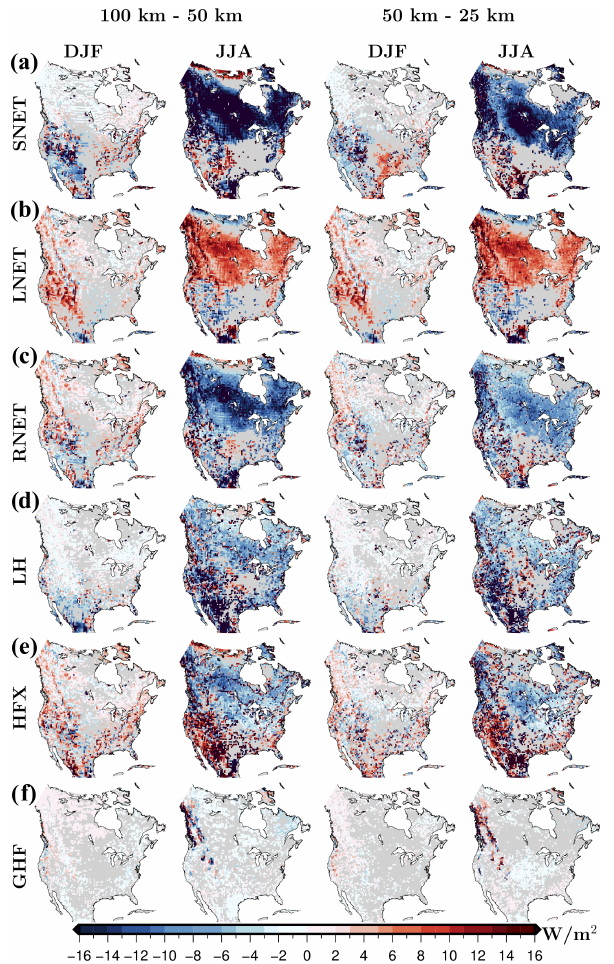
Figure 6. Seasonal mean difference in surface energy fluxes be- tween the 100 and 50km simulations (left) and between the 50 and 25km simulations (right). All outputs are from the NOAH-MP- DV simulations for the period 1980–2013. Grid cells with a non- significant change at the 5% significance level are masked in grey. All outputs from the 25, 50 and 100km simulations were mapped to a common grid (CRU grid) using the nearest model grid point.